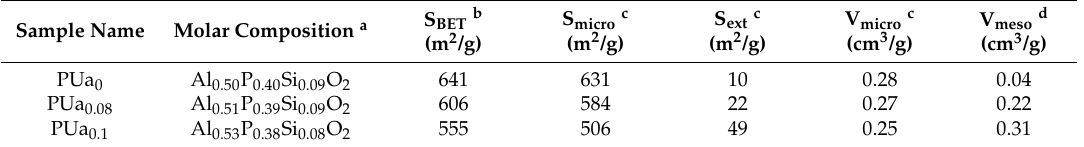
Table 1. Compositions and textural properties of different SAPO-34 samples.